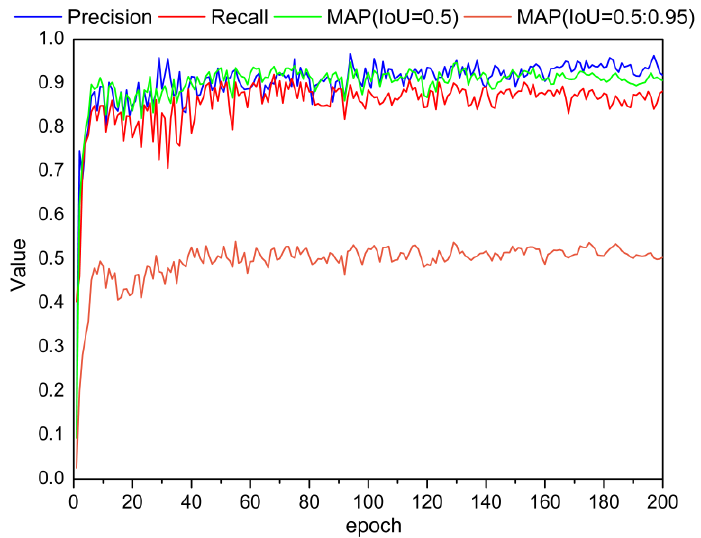
Figure 9. Changes in the values of the evaluation indicators of the model in the test set during the training process.